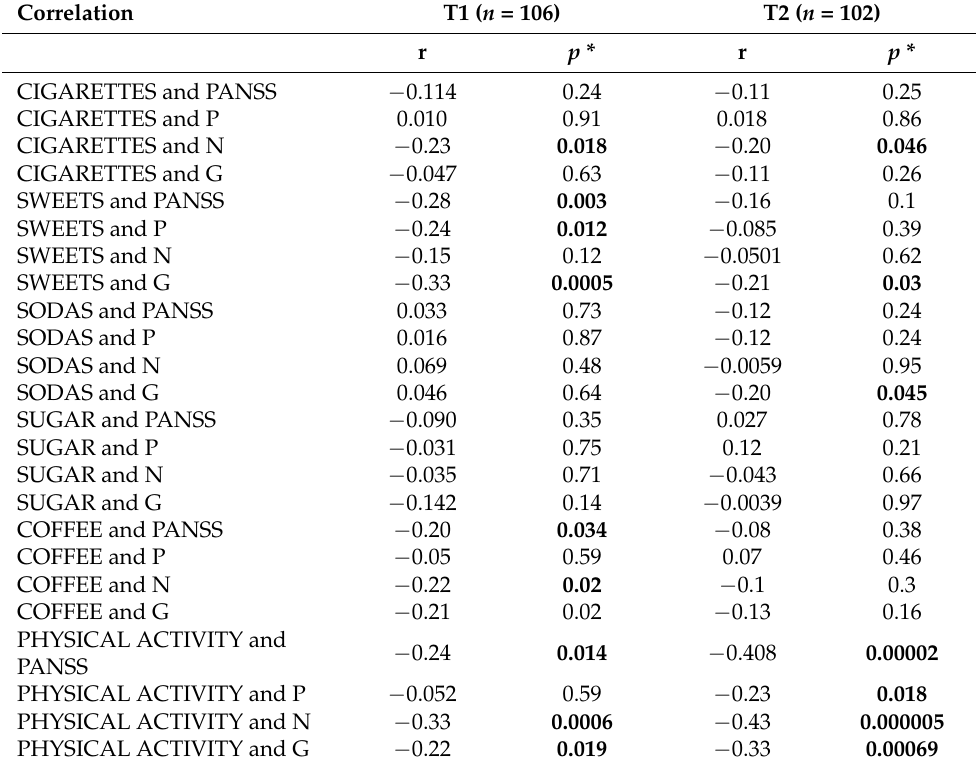
Table 3. Correlations between smoking, eating habits, physical activity and PANSS score at T1 and